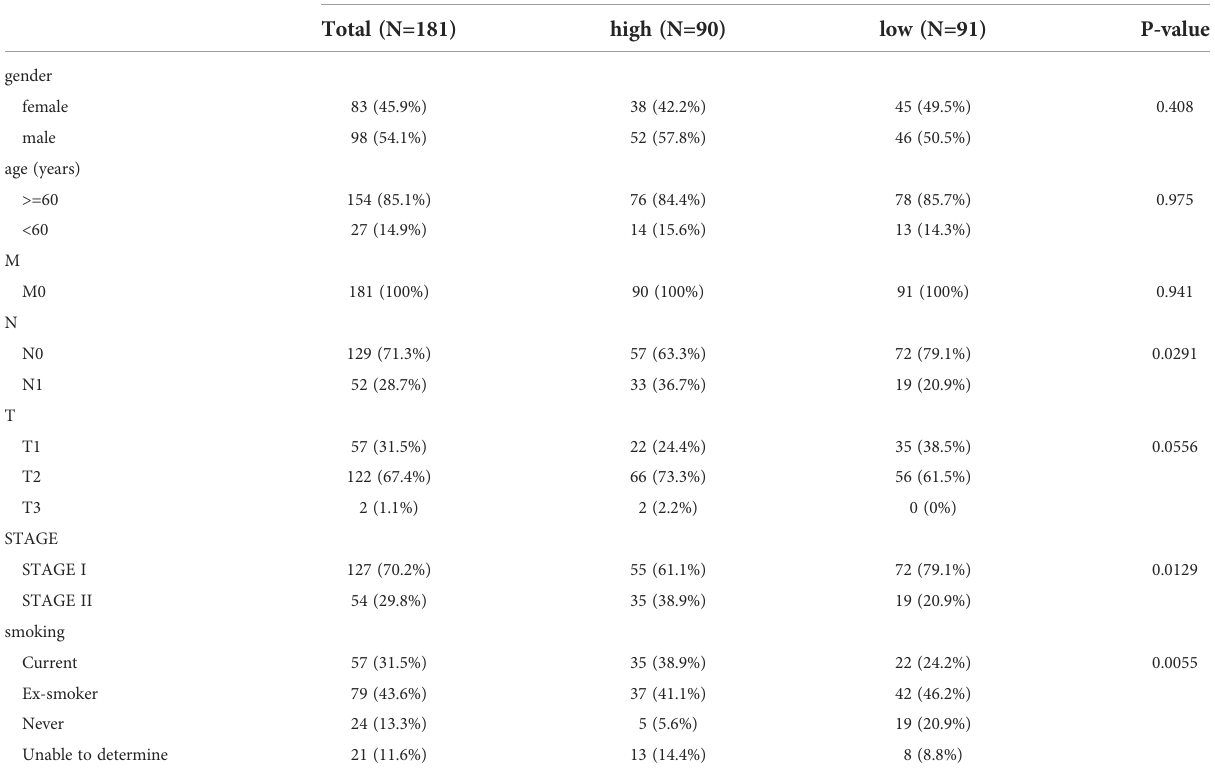
TABLE 5 Characteristics of patients in low and high risk groups GSE50081 dataset. Variable